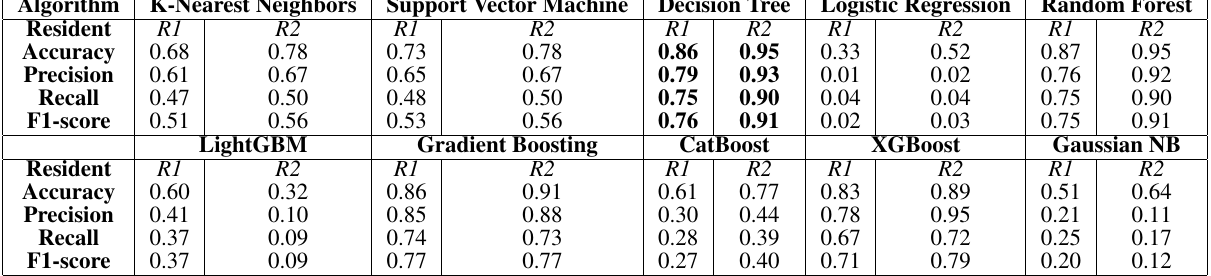
Table 1. Comparison of machine learning